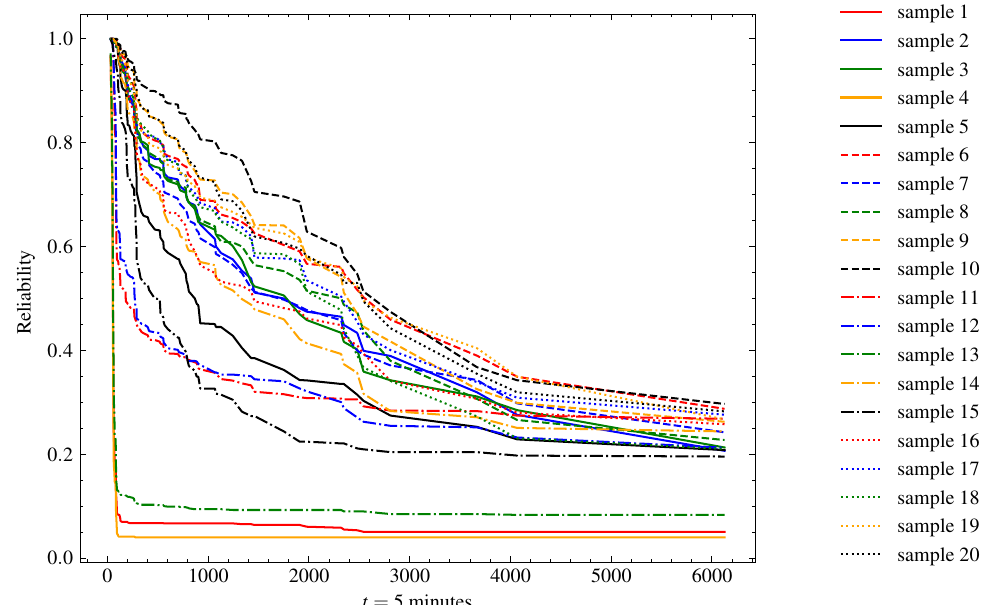
Figure 6. Reliability function estimate of test samples ( n = 20) using TSF-RSF. With the passage of time units (t), the probability of the system not failing declines. According to the measured variables, the model estimates whether the reliability decays more abruptly or not. After 400 5 min time units, stability in the operation of the generating units is